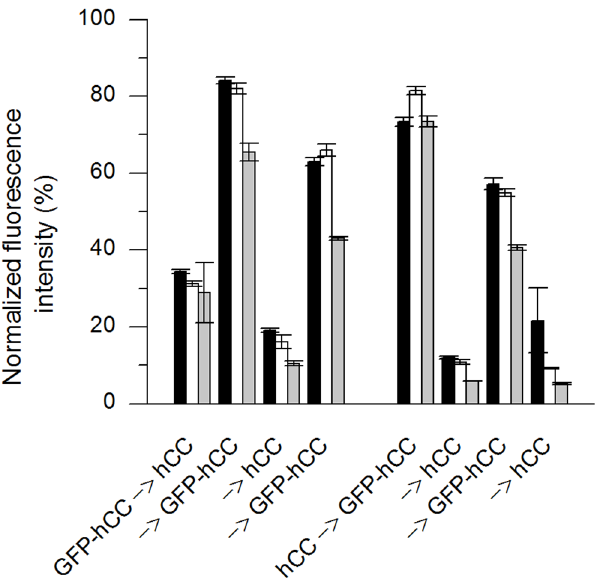
Fig 7. Repetitive replacement assay on mAb CyDI-4 using GFP-hCC and hCC. The repetitive replacement assay was carried out using GFP-hCC and hCC in both directions. The fluorescence intensity was read out after each replacement, and four times in total. The replacement antigens are indicated with an arrow (). Each assay was carried out in triplicate (error bars represent standard deviations). The background was subtracted from mean values and the resulting fluorescence was normalised to the positive control and was plotted as a percentage. The assay was carried out three times (n = 1 – 3 indicated as black, white and grey